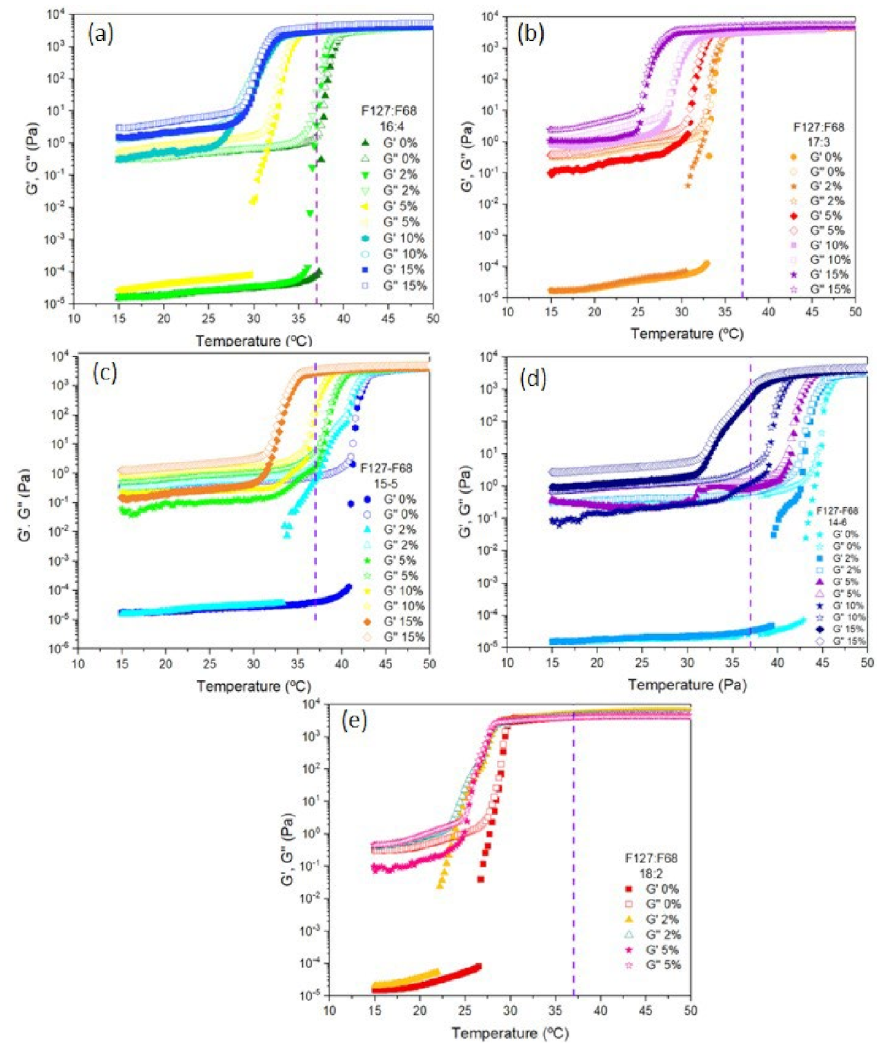
Figure 2. Elastic (G (cid:48) ) and viscous (G (cid:48)(cid:48) ) moduli of different microparticle concentrations (in w / w %) within Pluronic F127:F68 ratios of ( a ) 16:4; ( b ) 17:3; ( c ) 15:5; ( d ) 14:6; ( e ) 18:2. The violet dotted line represents 37 ◦